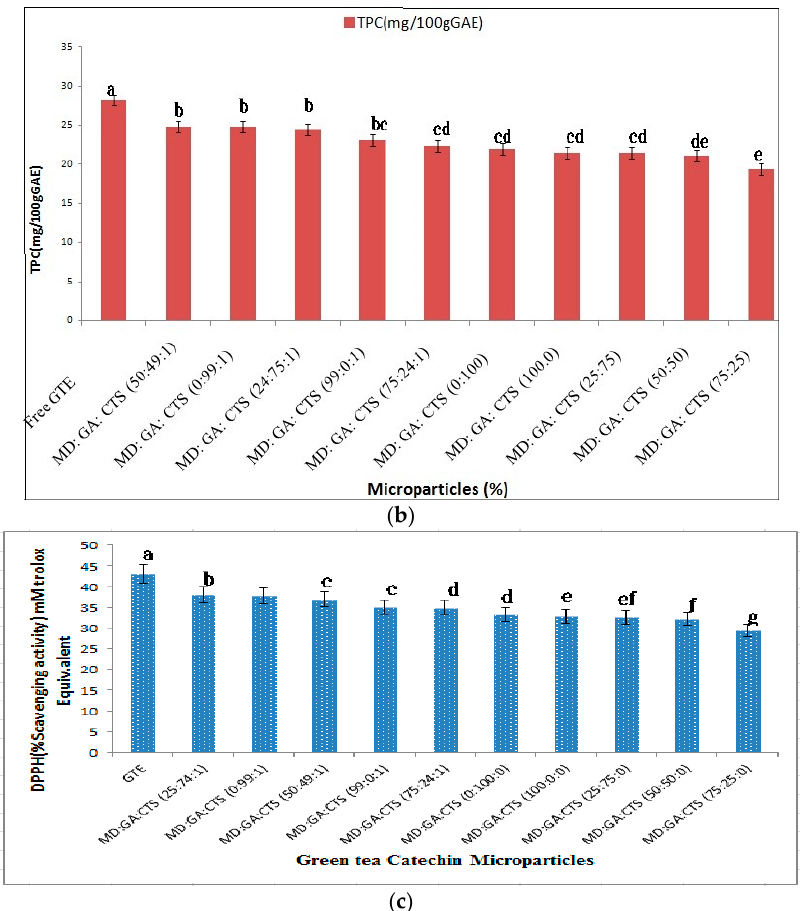
Figure 3. Effects of wall materials on ( a ) encapsulation efficiency of entrapped catechin; ( b ) total phenolic contents (TPC) of green tea microparticles; ( c ) DPPH radical scavenging activity of green tea microparticles. Values with different letters are significantly ( p ≥ 0.05) different. The values are represented as the means ± SD. (MD—maltodextrin, GA—gum arabic, CTS—chitosan).